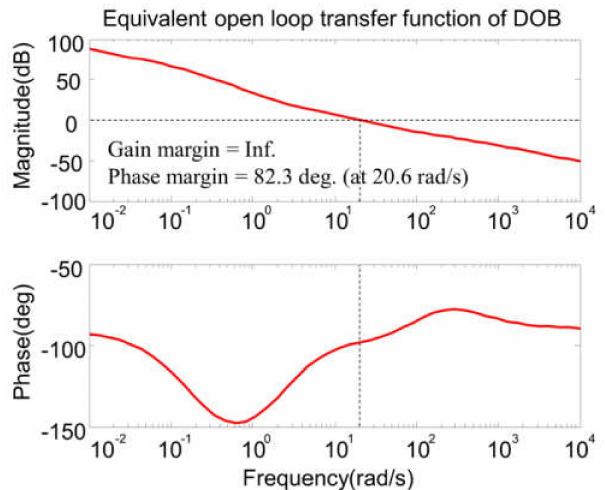
Figure 11. Bode plot of the equivalent open-loop transfer function of the controller.